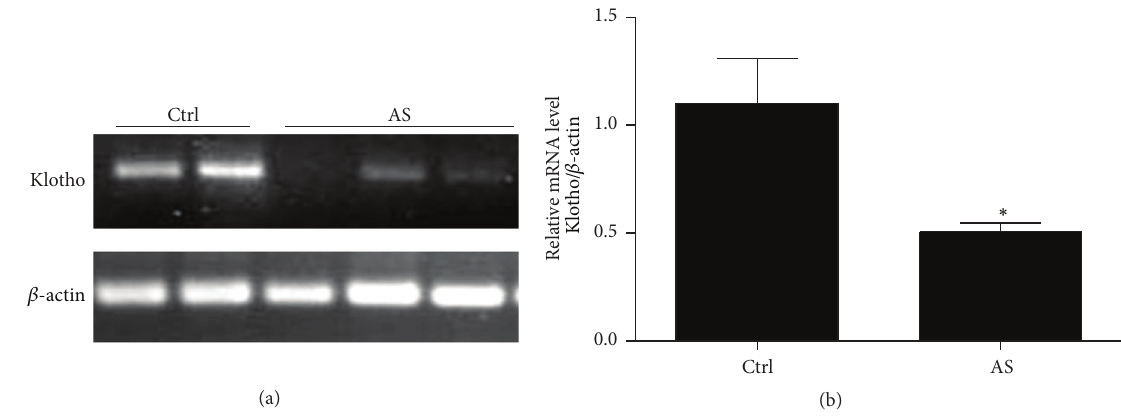
Figure 5: Decreased klotho mRNA expression in PBMCs from atherosclerotic patients. (a) PCR analysis of klotho mRNA expression. (b) Densitometric analysis of klotho PCR results. The values represent the means ± SDs ( 𝑛 = 4 in each group). ∗ 𝑝 < 0.05 versus Ctrl